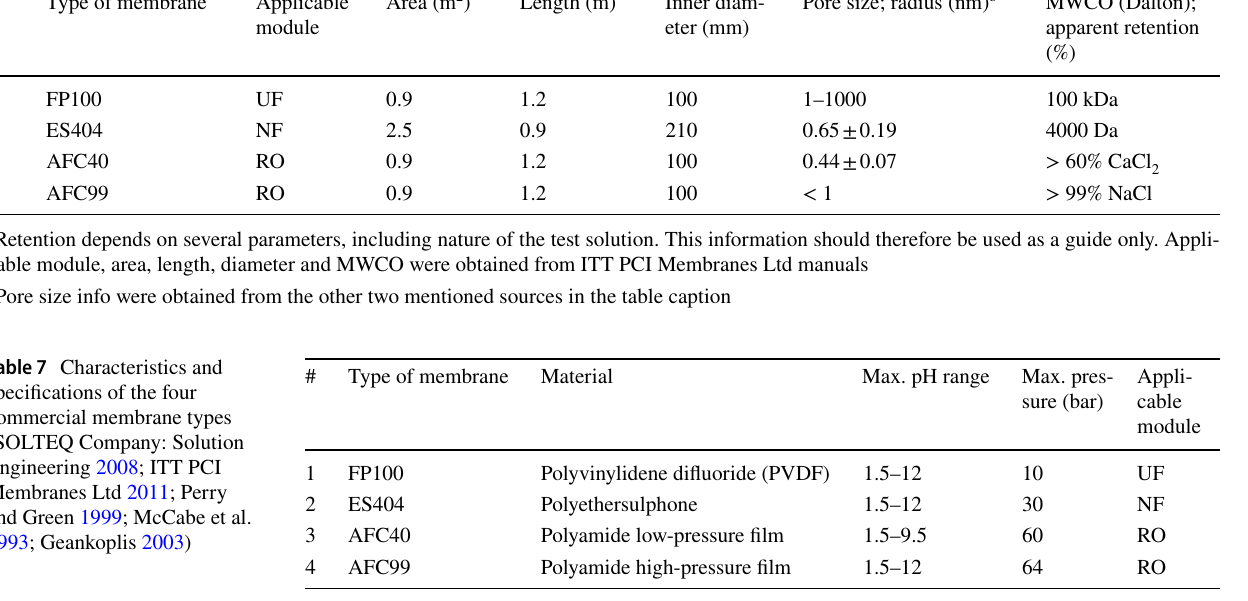
Table 6 Physical properties of the four commercial membrane types a (ITT PCI Membranes Ltd 2011; Khulbe et al. 2007; Otero et al. 2008)